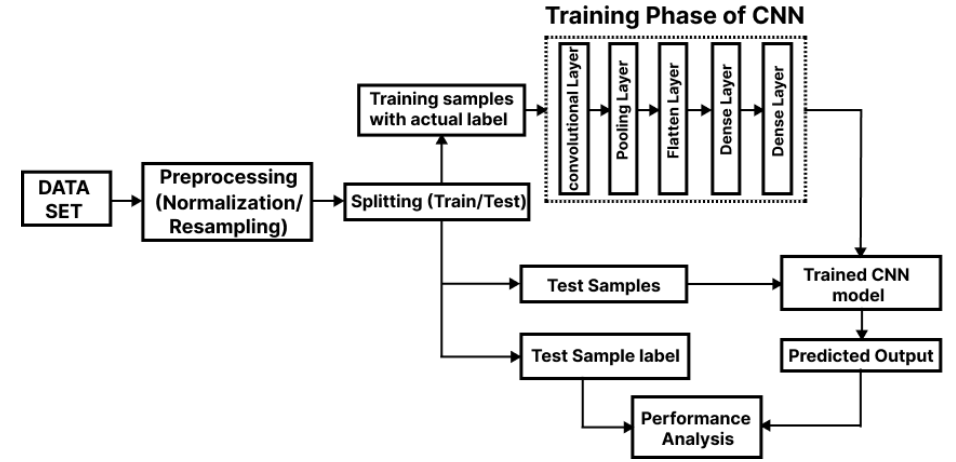
Figure 3. Proposed system architecture for fault